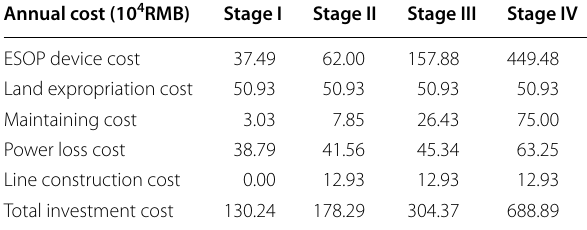
Table 4 Multi-stage investment cost in Case I